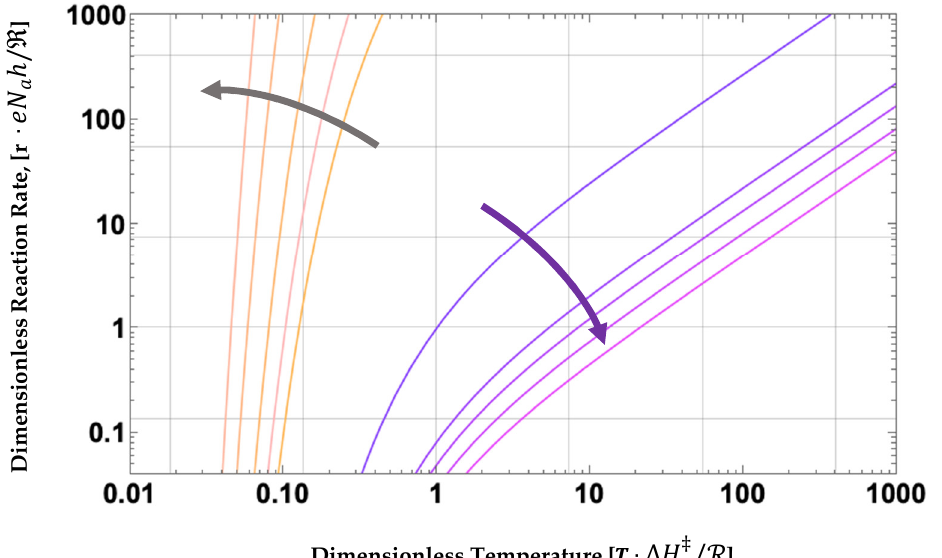
Figure 6. Log-Log parametric plot of reaction rates from Equation (17) vs. dimensionless temperature, T. The yellow-grey family of curves is for positive ∆ V ‡ ≡ 1, while the purple to red family of curves is for negative, ∆ V ‡ ≡ − 1. Pressure is increasing in the directions shown by the arrows.